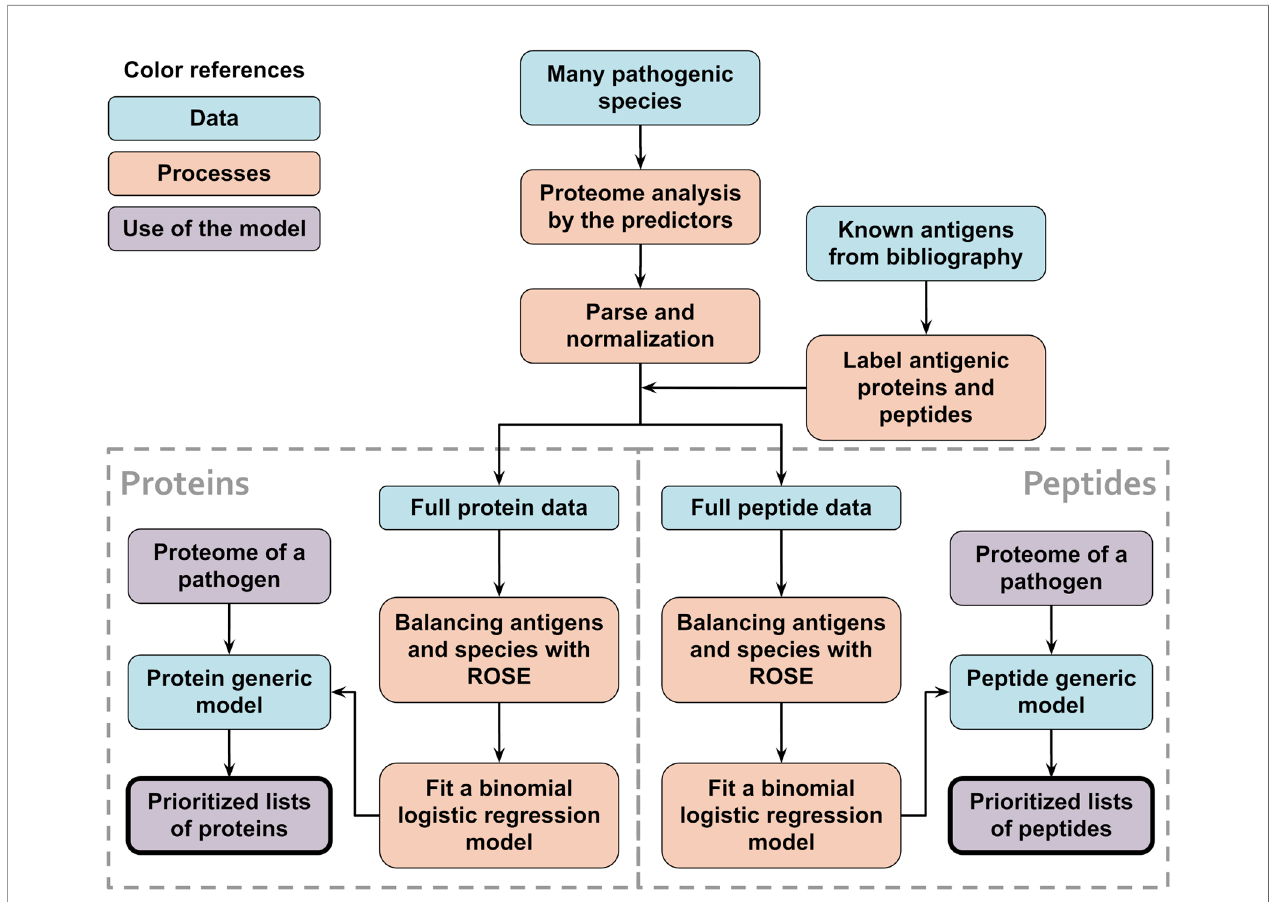
FIGURE 2 | Schematic fl owchart used to obtain APRANK ’ s generic models. With the aim of creating a set of models that could make predictions for a wide range of species, training and prioritization was performed for both proteins and peptides using combined data from all of our 15 species. When testing the generic models, leave-one-out models were used, where 14 species were used to train the models and the 15th species to test them. This process was repeated for all of our 15